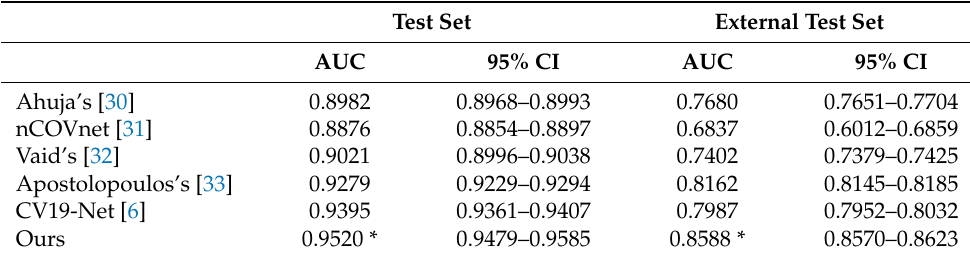
Table 2. Performance comparison of the proposed model with that of peer methods for the test set and the external test set in terms of AUC scores and 95% confidence interval (95% CI).